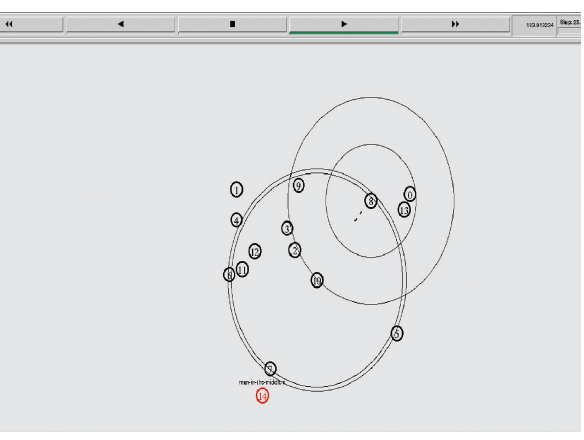
Figure 7: Simulation attack with 14 genuine nodes and 1 malicious node.